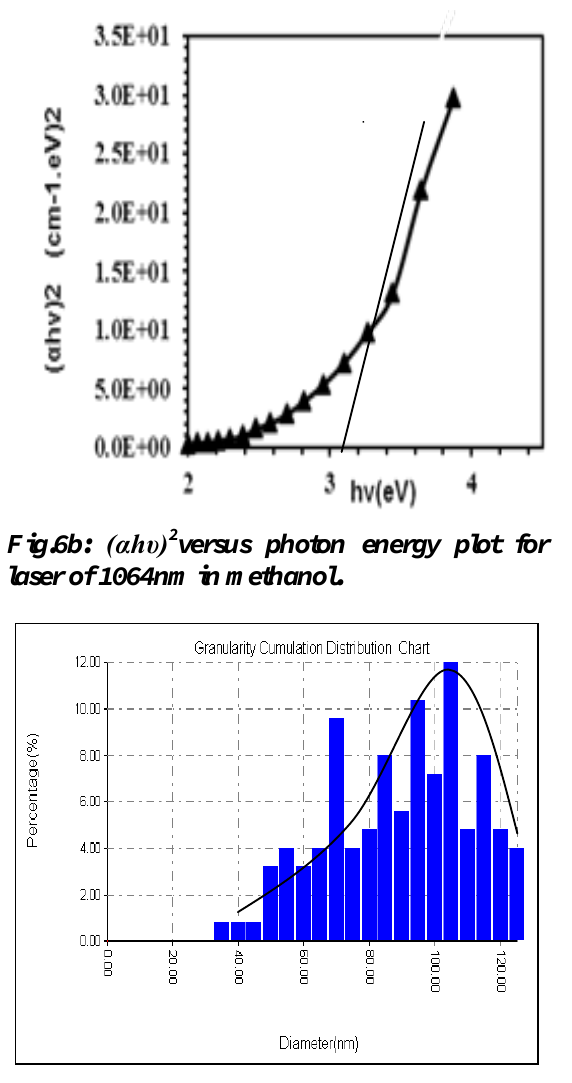
Fig. 7 a: AFM image of CdTe NPs. Fig. 7 b: Histogram of their size